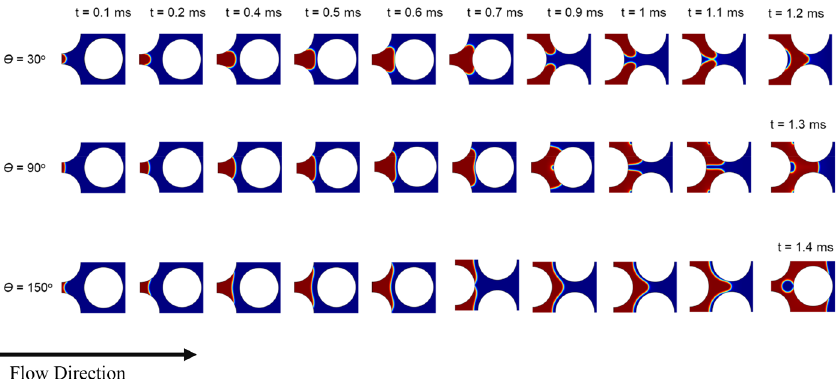
Figure 4. A sequence of pore-filling events (burst, touch and overlap) from left to right for a viscous fingering displacement of air (red) displacing water (dark blue). Top row: 30° contact angle through the denser phase represents strongly water-wet conditions or a drainage process, middle row: 90° contact angle represents intermediate wettability condition, and the bottom row: 150° contact angle through the denser phase represents strongly non-water-wet conditions or an imbibition process. Phase trapping was observed for all three contact angles, and in addition to the trapping due to menisci overlap, the touch event resulted in trapping at the upstream side of the